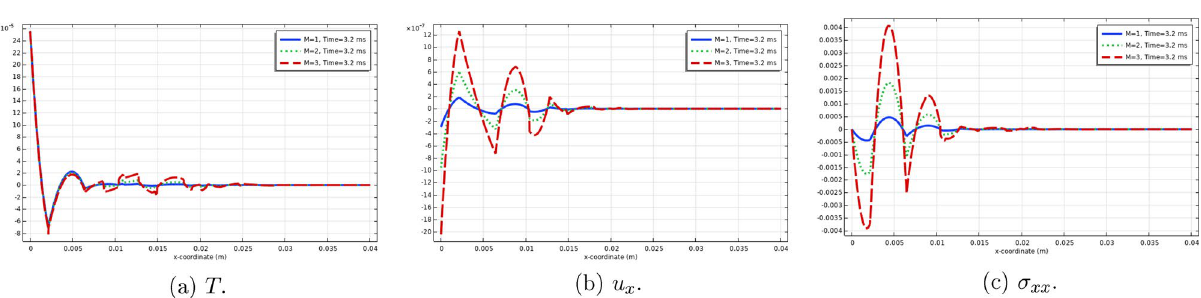
Figure 11. Top view of the distribution of σ yy in the slab at three consecutive time moments.